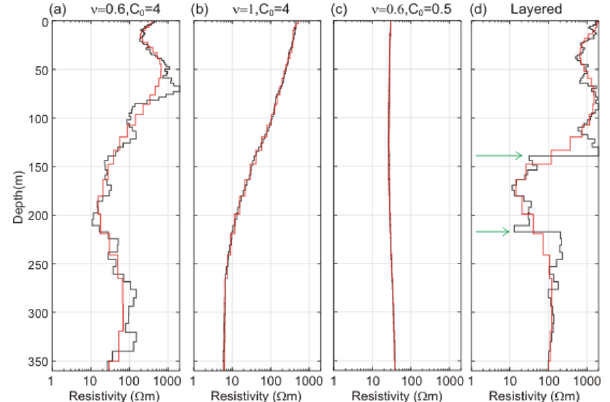
Figure 1. Examples of von Kármán models and the result after the forward and inversion process, where black curves show von Kár- mán models (re-discretized to 90 layers), and the red curve shows the final model. Panels (a) to (c) are for the combination of ν and C 0 stated in the title; panel (d) is for a stitched, layered model (green arrows mark the imposed sharp layer boundaries). The red curves show the obtained model from inversion of the forward response of the black